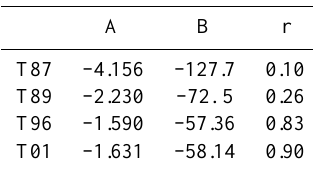
Table 2. Model coefficients of the best fit between onset loca- tion and dipole tilt. The model was X GSM = Aθ + B , where θ is the dipole tilt angle. The third column indicates the correlation coeffi- cient for the best